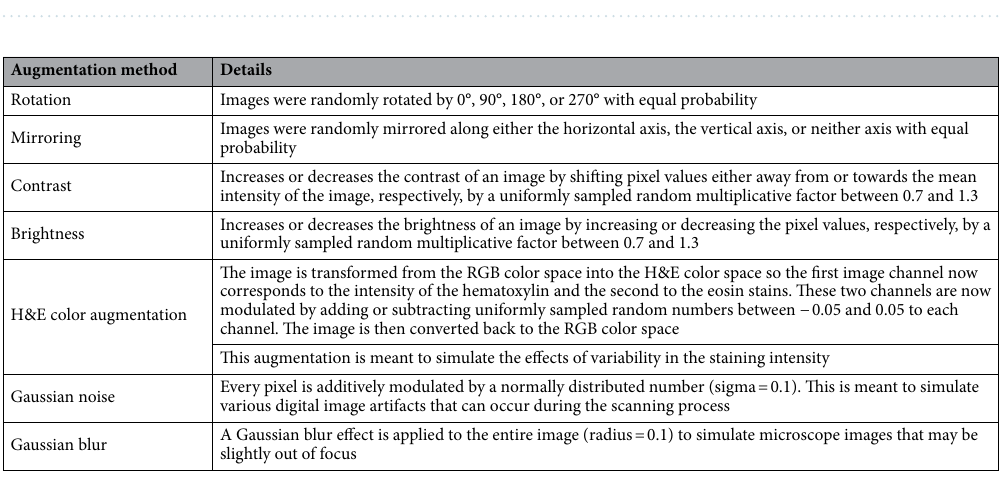
Table 1. Data augmentations applied during training.